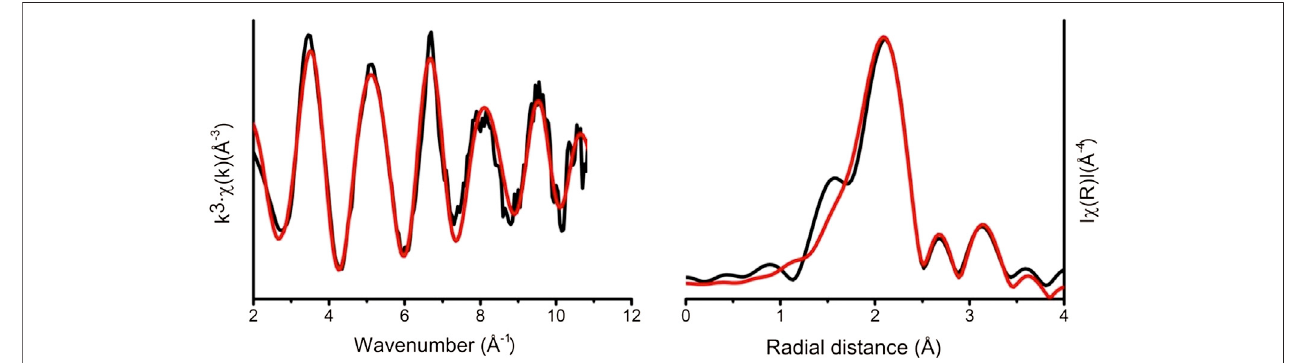
FIGURE 4 | Sr K-edge extended X-ray absorption fi ne structure experimental data (black line). Theoretical best fi t (red line) calculated using Artemis (Ravel and Newville, 2005).